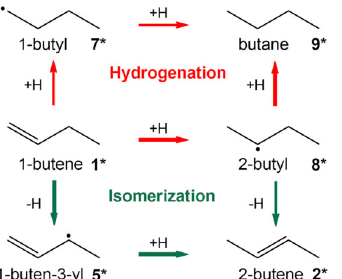
Fig. 1 Reaction network for 1-butene isomerization, green, and hydrogenation, red, on Pd catalysts. Hydrocarbon species are identi fi ed using bold numbers consistent with ref. 8 .